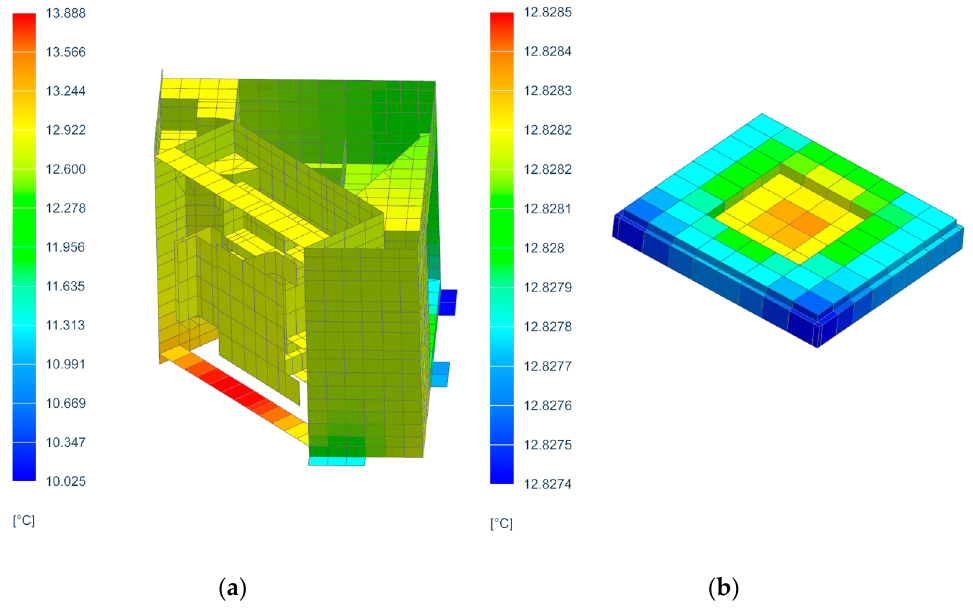
Figure 11. Temperature clouds of CMOS components in the low-temperature case ( a . Heat dissipa- tion component; b . CMOS).